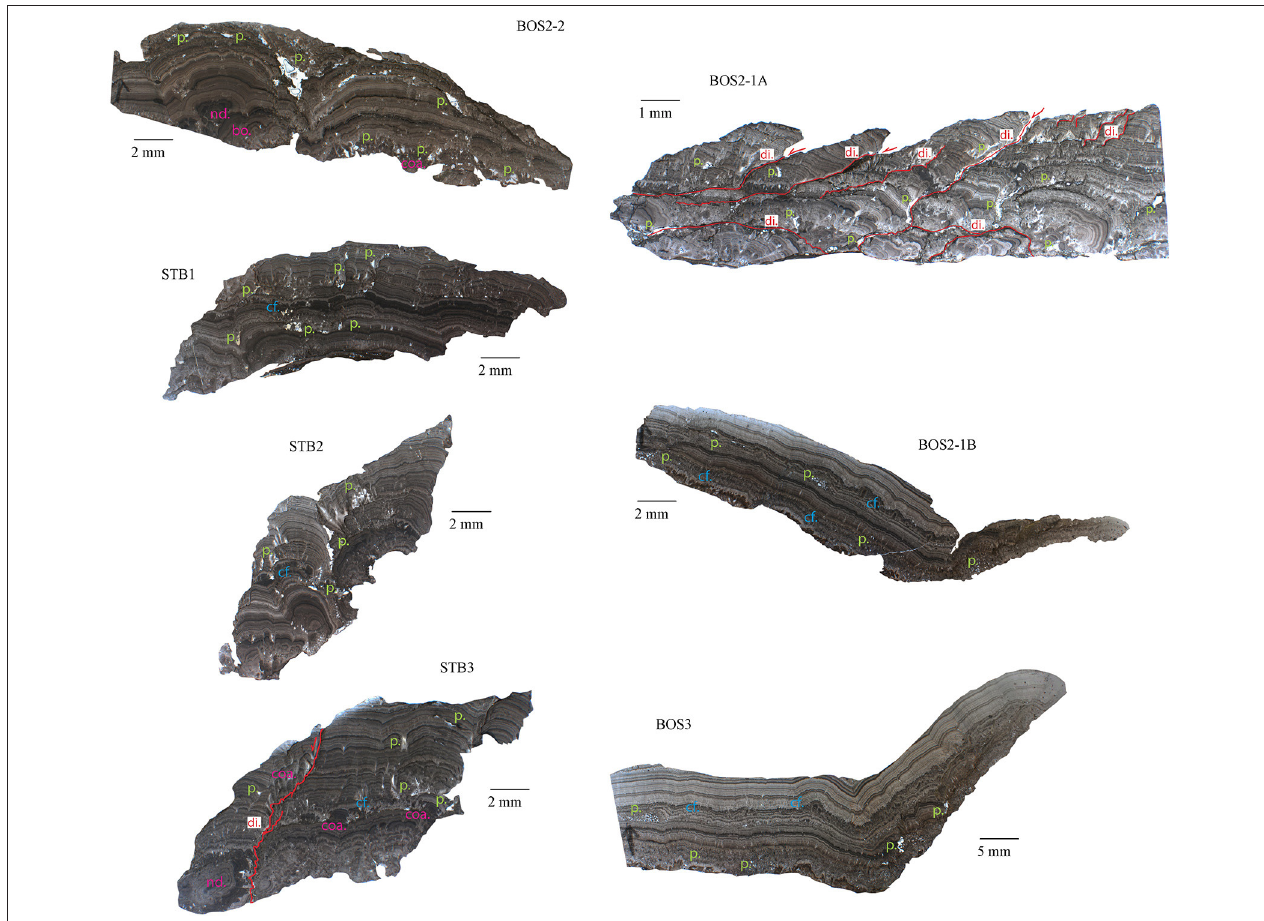
FIGURE 3 | Sedimentary structures identified within samples BOS2-1A, BOS2-1B, BOS3, BOS2-2, STB1, STB2, and STB3. Symbols: p., porosity; di., dissolution structures; cf., fibrous calcite; bo., botryoid; coa., coalescent fabric; nd., nodular fabric.